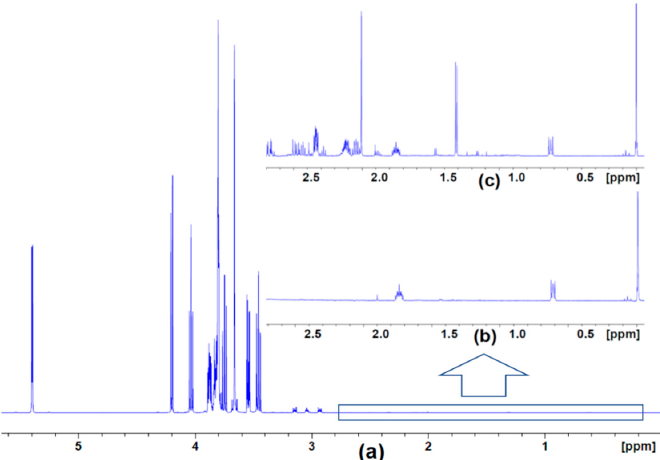
Figure 1. 1 H nuclear magnetic resonance (NMR) spectra of the SYN-Per reagent alone and after its use in extracting metabolites from synaptosomes obtained from control animals. ( a ) Full spectrum of SYN-Per showing the predominant peaks between 3.5 and 4.3 ppm and at 5.4 ppm. ( b ) Expansion of the boxed region of ( a ), which exhibits smaller signals from DSS (sodium trimethylsilylpropanesulfonate) along with the major DSS peak at 0 ppm. ( c ) Same spectral region as in ( b ) following extraction of metabolites from control animals; the additional peaks are ascribed to extracted metabolites.